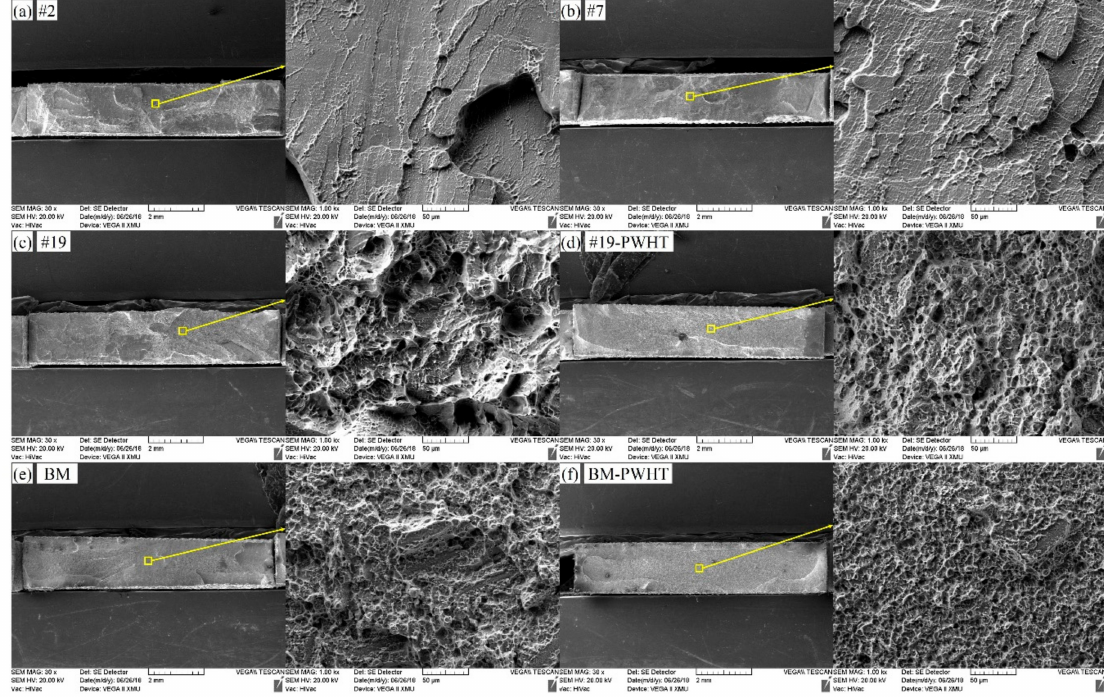
Figure 13. The tensile fractures of laser welded Ti55531 joints of ( a ) #2: P = 2 kw, v = 2 m/min, f = 0 mm; ( b ) #7: P = 2.5 kw, v = 2 m/min, f = +3 mm; ( c ) #19: P = 3.5 kw, v = 4 m/min, f = 0 mm; ( d ) #19 after PWHT, (e) BM and (f) BM after